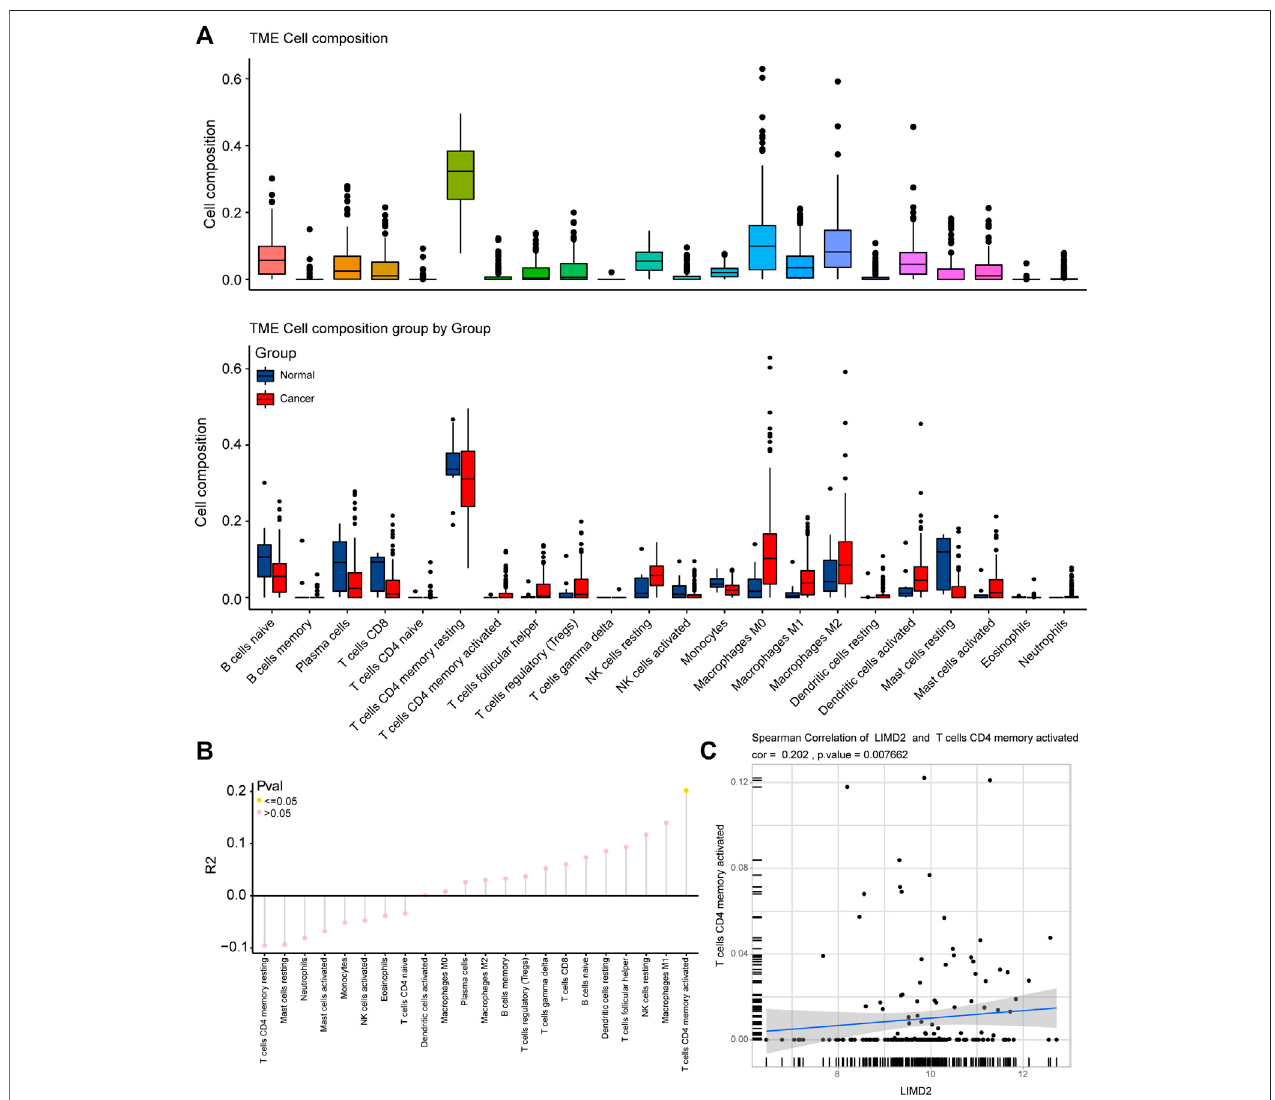
FIGURE 6 | Immune in fi ltration correlation analysis in ECA based on TCGA cohort. (A) Fraction of the immune tumor microenvironment (TME) cells in the ECA and normal groups, and TME cells between the ECA and normal groups are analyzed in the fi gure given below. Within each group, the scattered dots represent the expression values of TME cells. The bottom and top of the boxes are the 25th and 75th percentiles (interquartile range). The whiskers encompass 1.5 times the interquartile range. (B) Immune in fi ltration correlation analysis; (C) Plots showing Spearman ’ s correlation of LIMD2 and memory activated CD4 T cells.